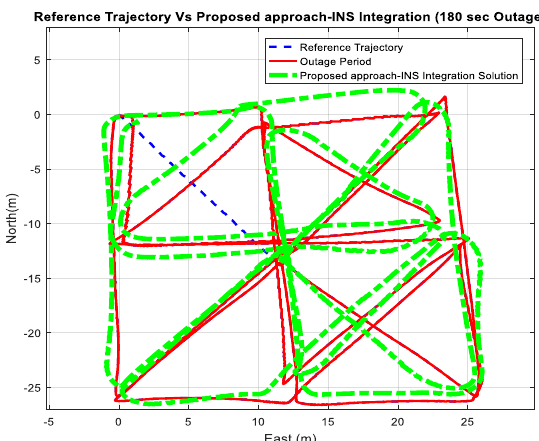
Figure 11. Performance of the integration between the proposed approach (camera with UWB) and INS for 180 seconds of